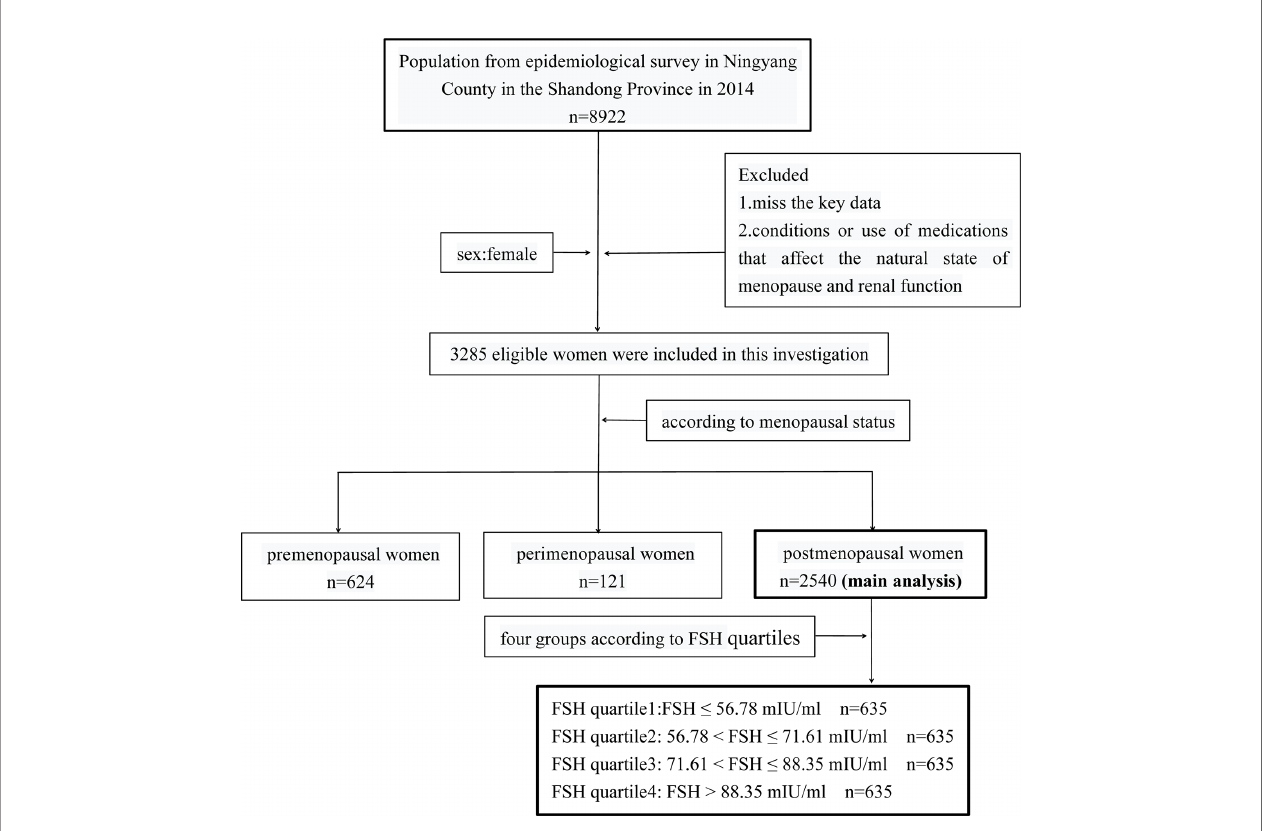
FIGURE 1 | Flow chart for selection or